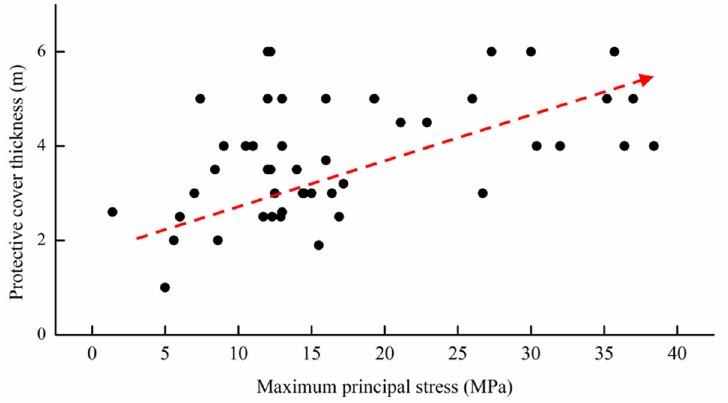
Figure 15. The relationship between protective cover thickness and in situ stress level at the rock anchor beam zone.